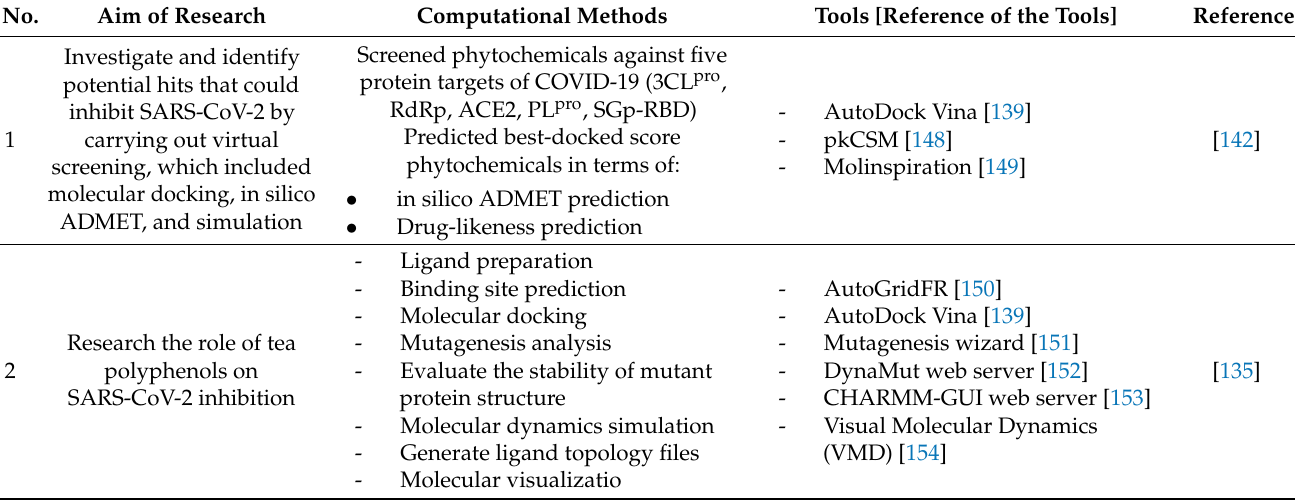
Table 4. Relevant computational methods and bioinformatics tools to research antiviral agents and probiotics against